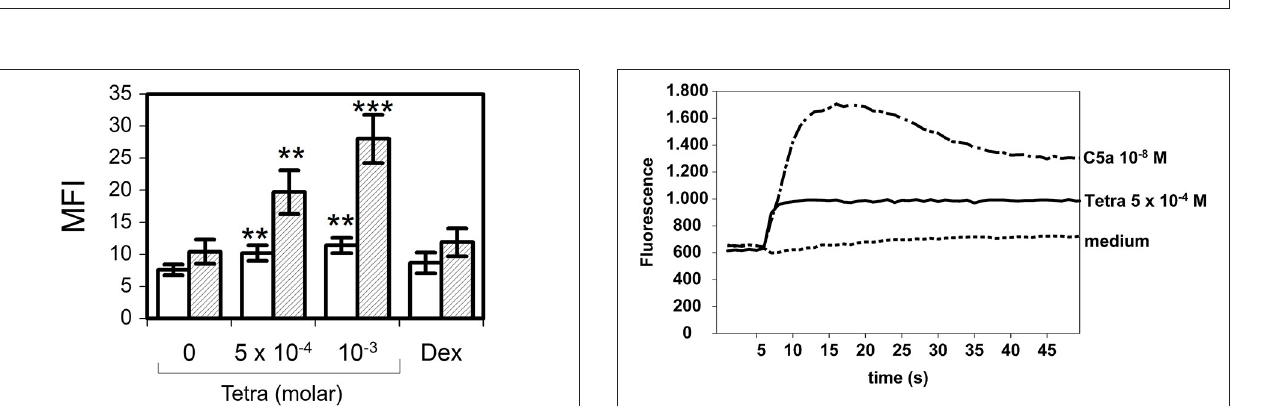
Frontiers in Allergy |